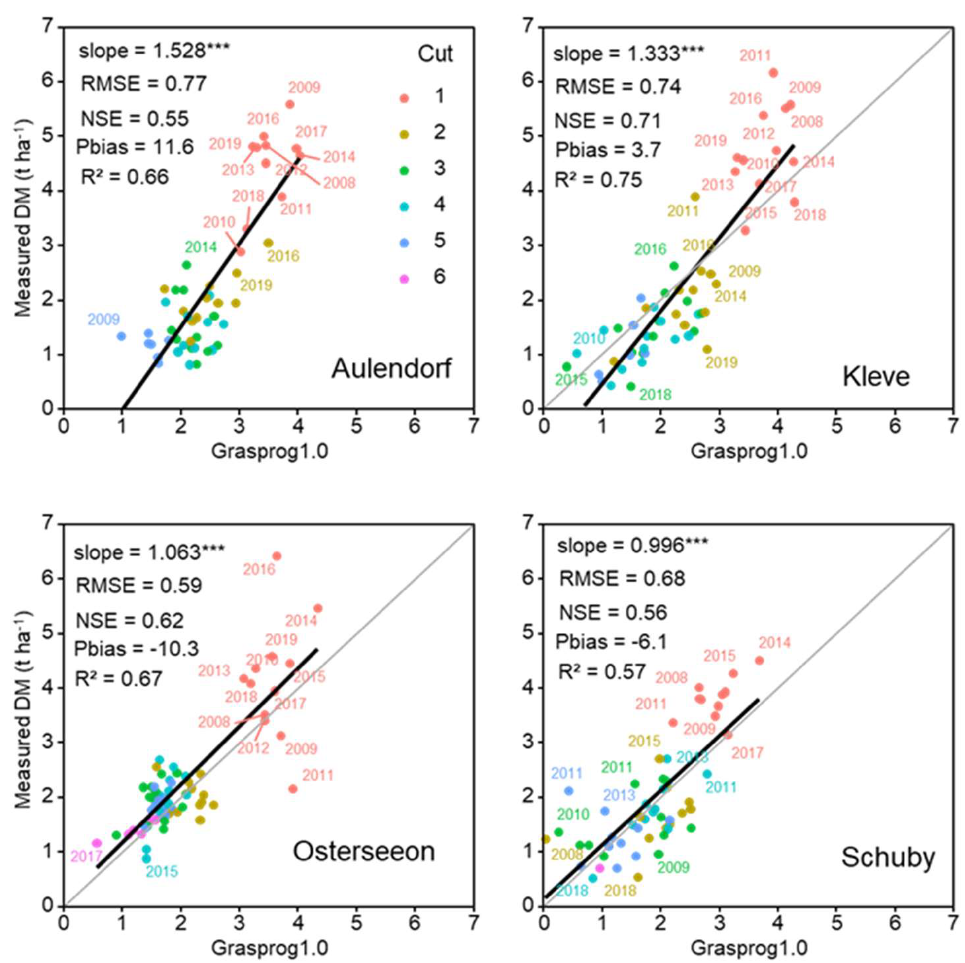
Figure 9. Measured grass dry matter (DM) vs. predictions by GrasProg1.0 for different cuts and years for Aulendorf, Kleve, Osterseeon, and Schuby, Germany. *** indicates significance p < 0.001.